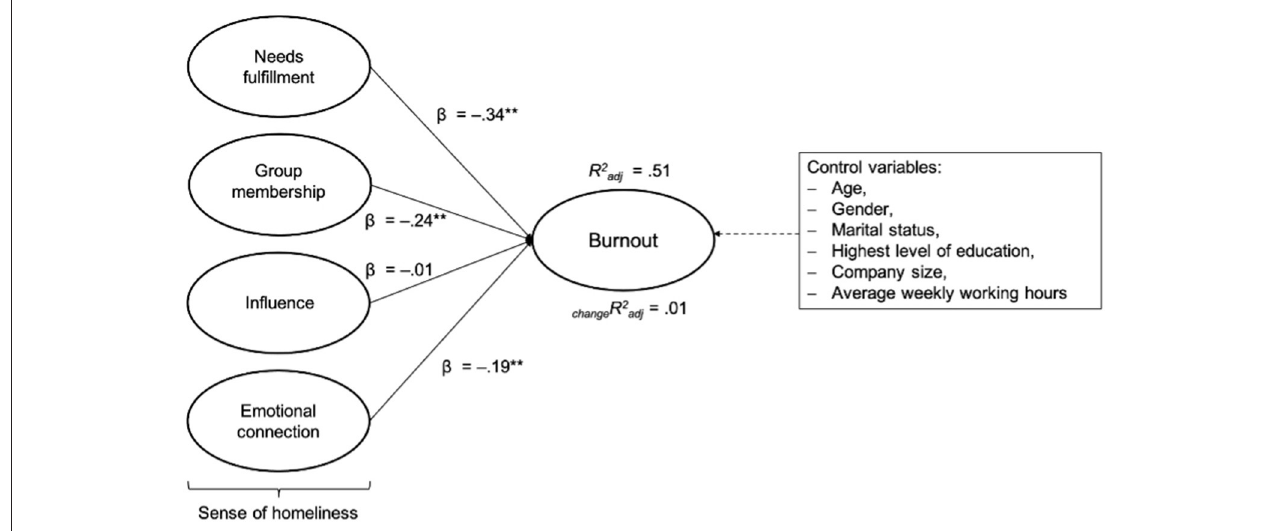
FIGURE 3 | Multiple regression analysis with the total burnout score as a dependent variable and needs fulfillment (NF), group membership (GM), influence (IN), and emotional connection (EC) as independent variables (step 1); change R 2 adj after incorporating the control variables (step 2). R 2 adj = R 2 adjusted; change R 2 adj = change in R 2 adjusted; * p < 0.05; ** p <